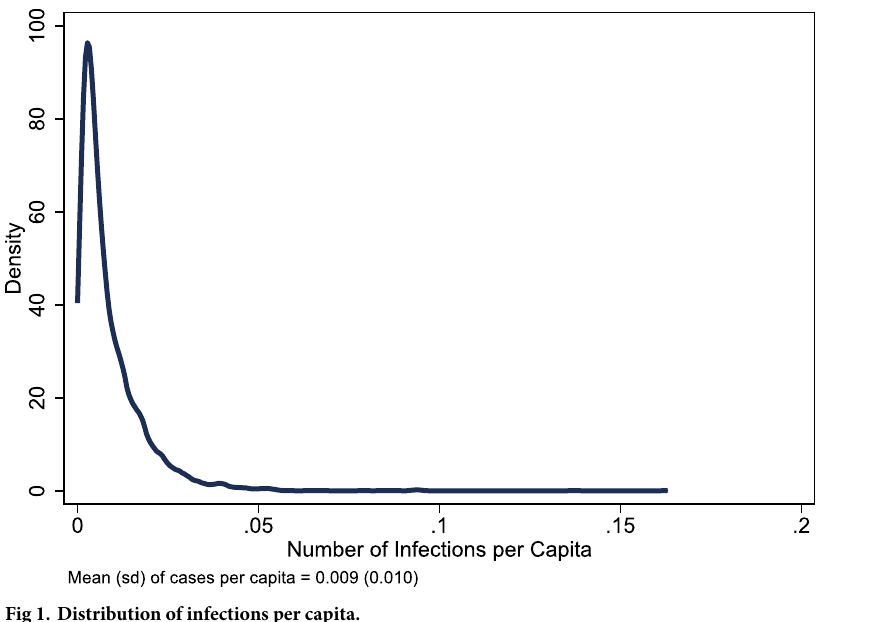
Fig 1. Distribution of infections per